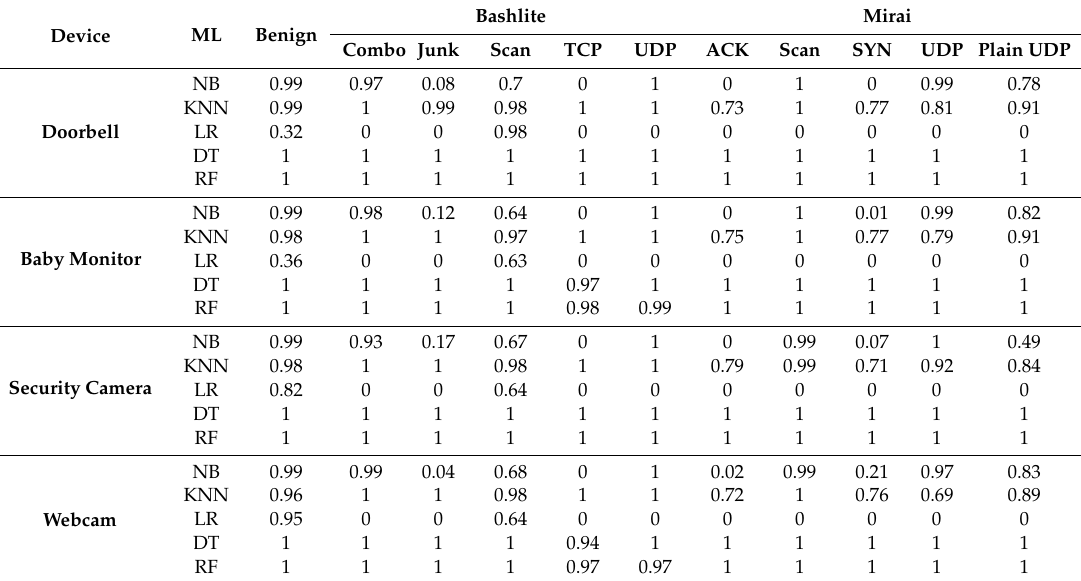
Table 11. F1-score of each model based on the ML model.